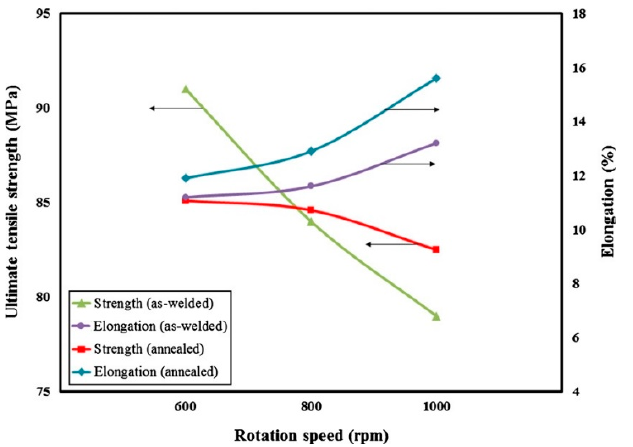
Figure 3. Variations in ultimate tensile strength and elongation of FSWed joints of 1XXX pure Al alloy in as-welded (work hardened) and annealed conditions versus rotation speed [42]. Reprinted